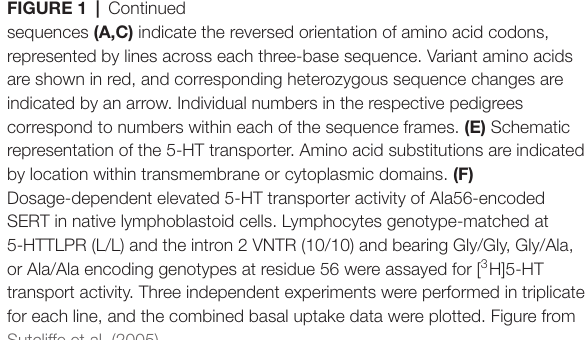
Dosage-dependent elevated 5-HT transporter activity of Ala56-encoded SERT in native lymphoblastoid cells. Lymphocytes genotype-matched at 5-HTTLPR (L/L) and the intron 2 VNTR (10/10) and bearing Gly/Gly, Gly/Ala, or Ala/Ala encoding genotypes at residue 56 were assayed for [ 3